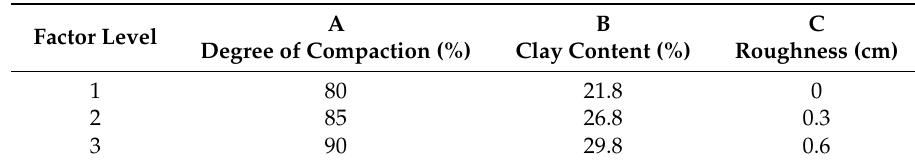
Table 2. Level of influence factors.